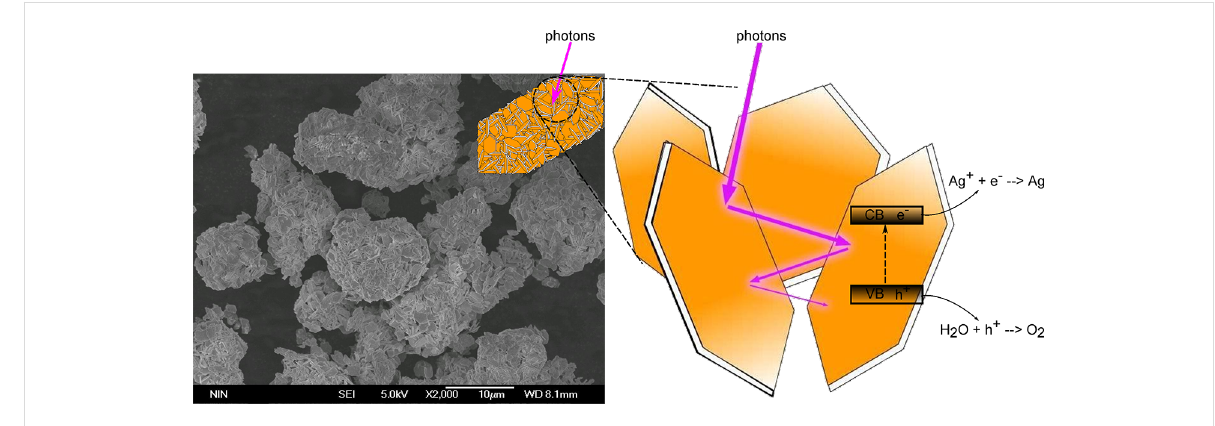
Figure 7: Enhanced light absorption ascribed to multiple light reflections in the nanosheet-based hierarchical structure.